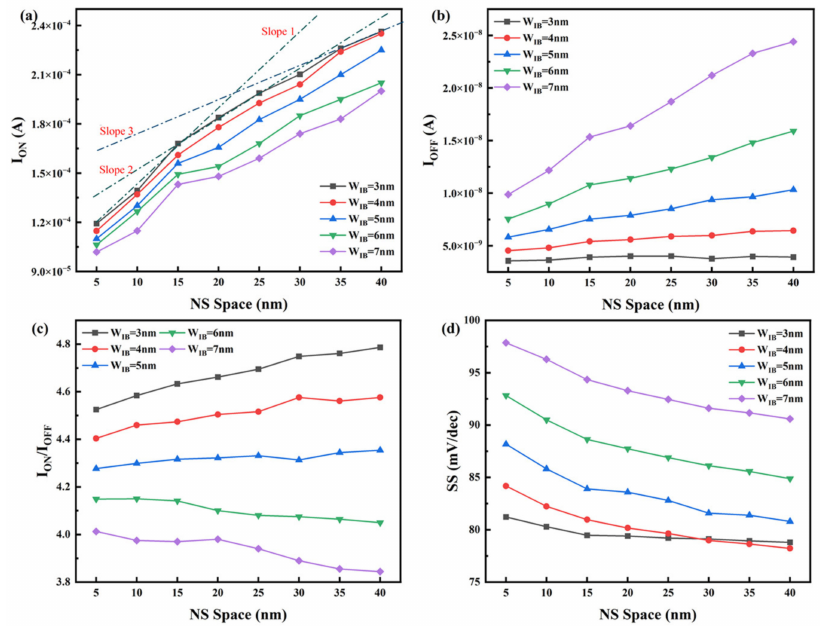
Figure 7. Impact of S NS : ( a ) I ON ; ( b ) I OFF ; ( c ) I ON /I OFF ; and ( d ) SS of the TreeFET with different W IB at V GS = V DS = 0.7